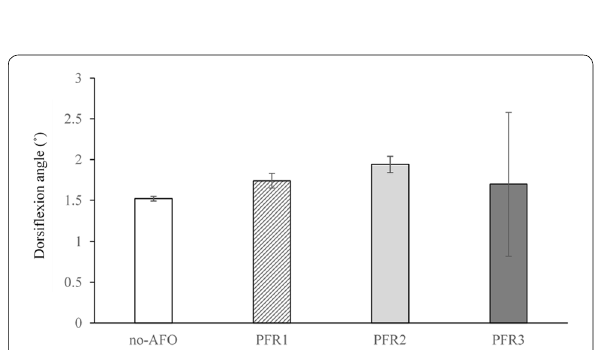
Fig. 5 Minimum dorsiflexion angle in early stance. The error bars represent 1 standard deviation from the mean ±